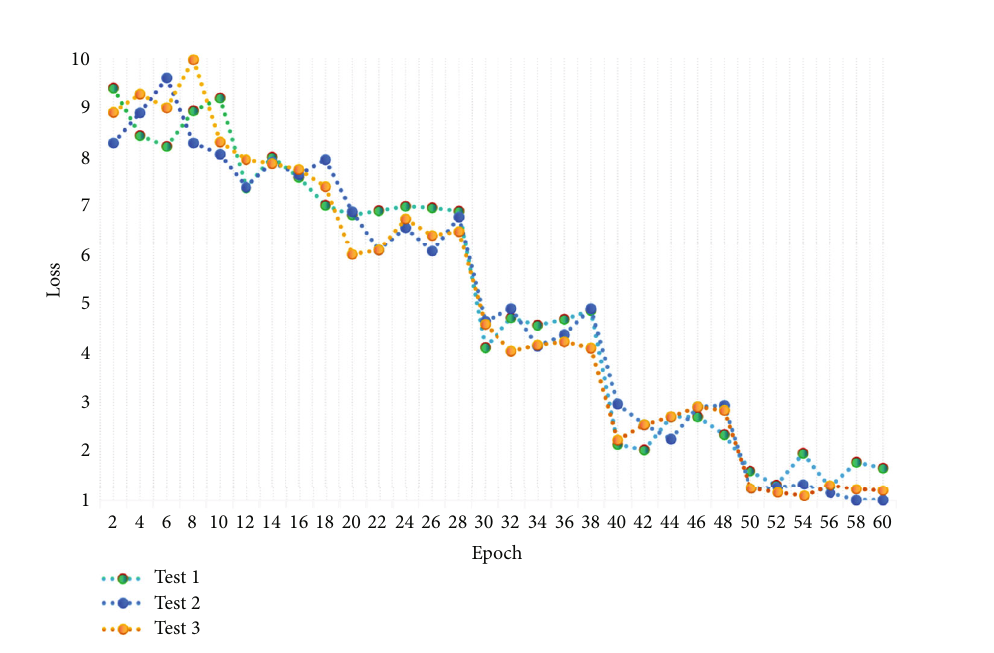
Figure 3: Training of the algorithm.